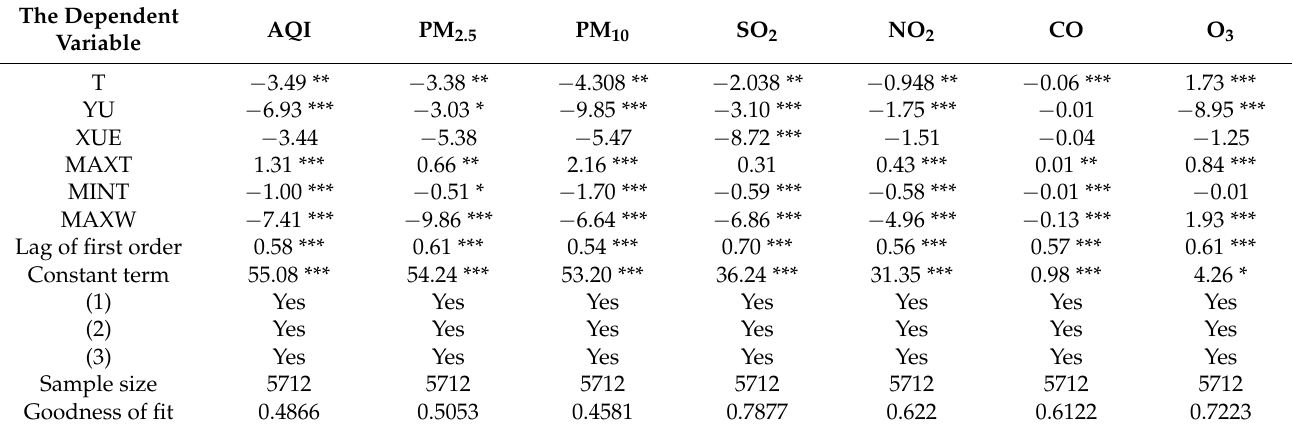
Table 2. Dynamic panel fixed effects of LSDV estimation